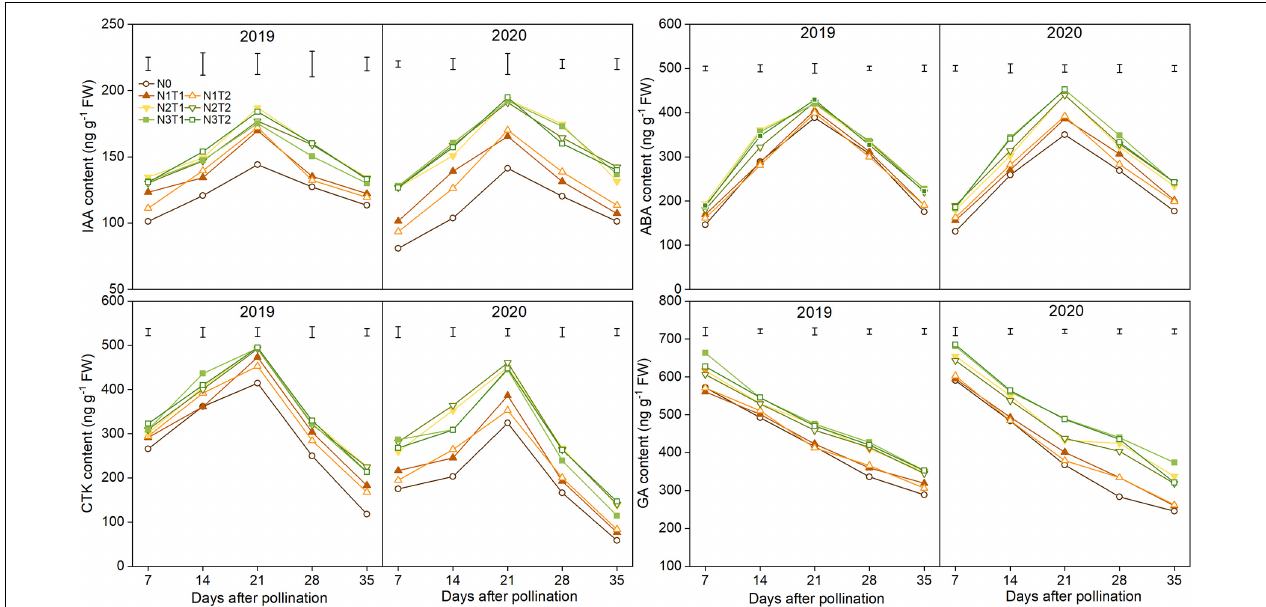
FIGURE 6 | Effects of N rate and time on the content of indole-3-acetic acid (IAA), cytokinin (CTK), abscisic acid (ABA), and gibberellic acid (GA) in 2019 and 2020. The vertical bars represent the LSD ( n = 3).